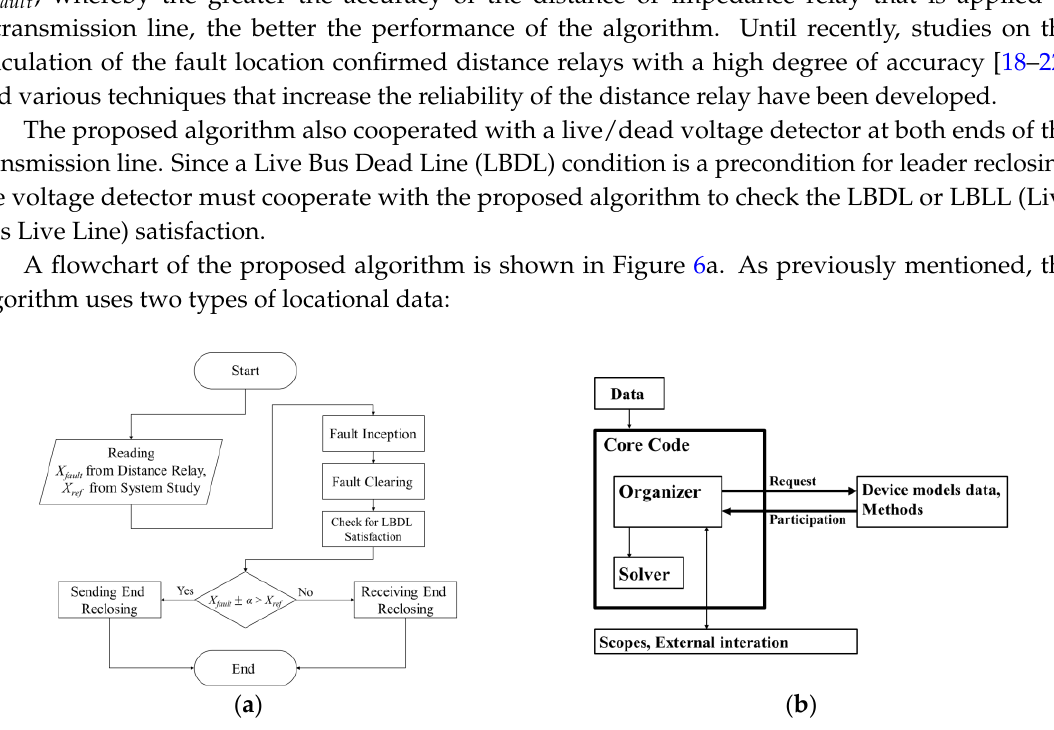
Figure 6. Flowchart of the proposed algorithm and the relationship between the DLL code and EMTP program: ( a ) Flowchart of the leader-end-reclosing algorithm for the permanent fault; ( b ) Request-participation relationship between the core code and device models in EMTP-RV